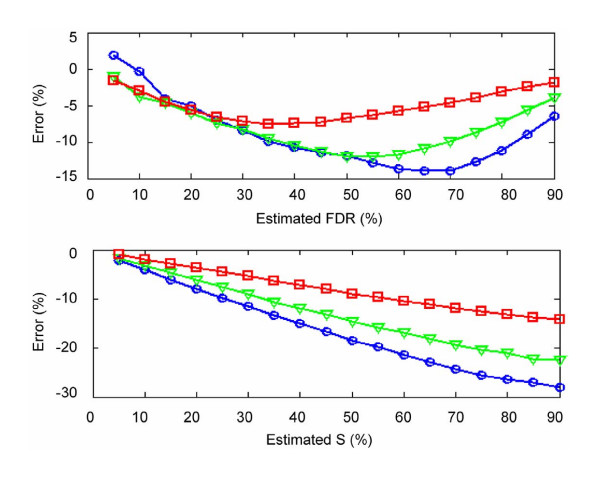
Error of FDR and S estimators. Comparisons were made between two groups of 2, 3 or 5 replicates. The first group is composed of synthetic data sets made from the experimental replicates Wt-t0a and Wt-t0b, in which 1000 genes (500 increased and 500 decreased) are changed (p <= 0.10), and the second group is composed of synthetic data sets without extra variation. Ten comparisons with different combinations of data sets were made, and the resulting mean errors of FDR (upper panel) and S (lower panel) for several values of the estimator (5 to 90%, by steps of 5%) are plotted (error is computed by substracting the estimated value from the real value and expressed in relative percentage point difference). Replicates 2, 3 and 5 are marked, respectively, by blue circles, green triangles and red squares.